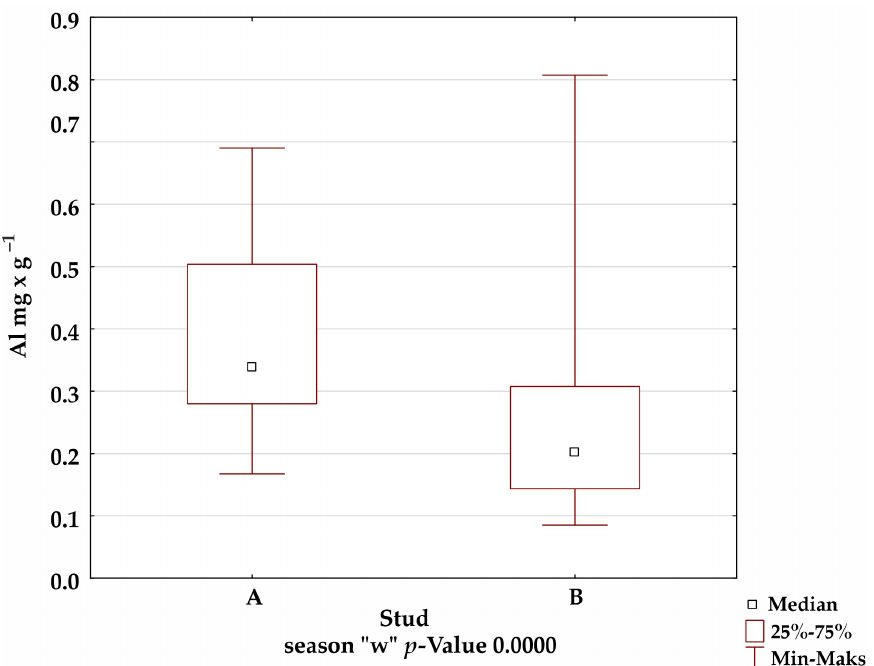
Figure 1. Comparison of trace-element levels between stables in each season, for which the signifi- cance of differences was confirmed by Kruskal–Wallis test.